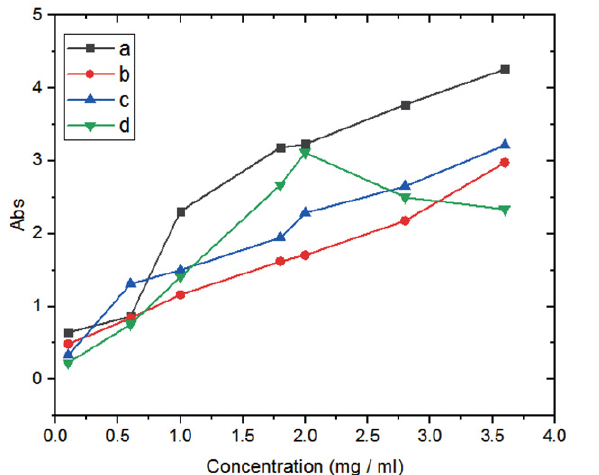
Figure 9. The DOX adsorption at different concentrations using, a (Gr Mn / GO / CS / A. sativum / Que) b ( Free DOX ) C (Mn CS) d (Mn / GO / CS / A. sativum /